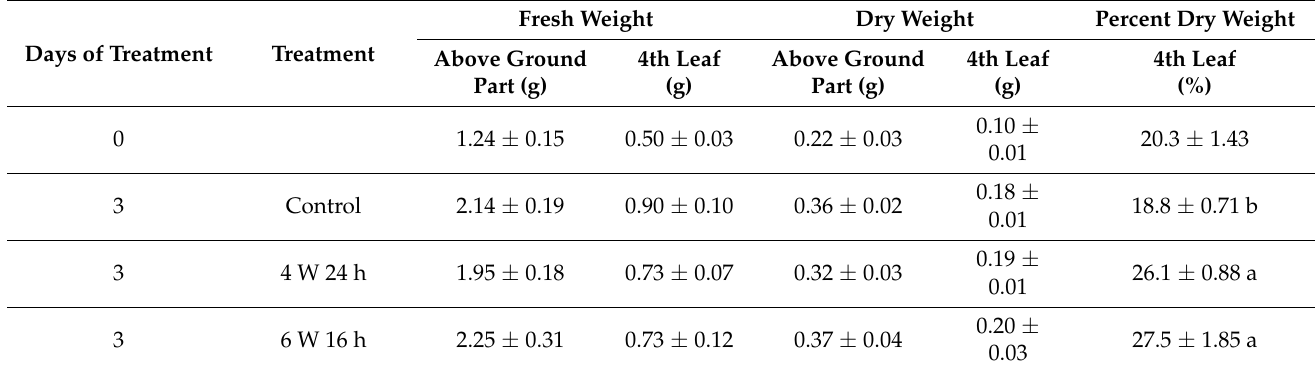
Table 2. Effect of UV irradiation on growth of the above-ground parts and 4th leaf of red perilla after 3 d of UV-B treatment [experiment 2]. The plants were exposed to UV-B irradiation at 0 W m − 2 (control), 4 W m − 2 at continuous irradiation (4 W 24 h), and 6 W m − 2 for a 16 h light period (6 W 16 h).